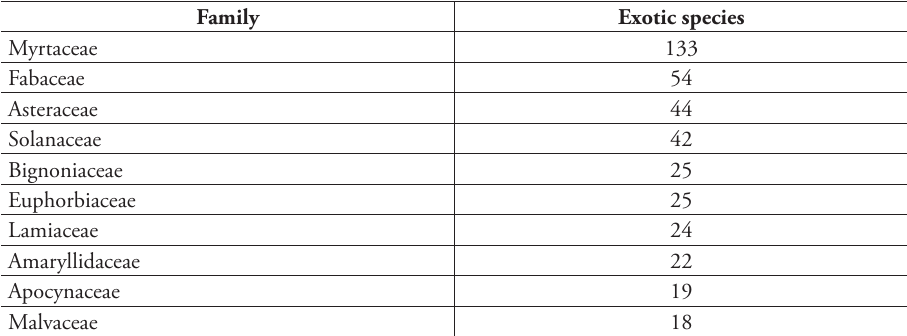
Table 3. The number of exotic plant species of the top ten families in Kenya. Family Exotic